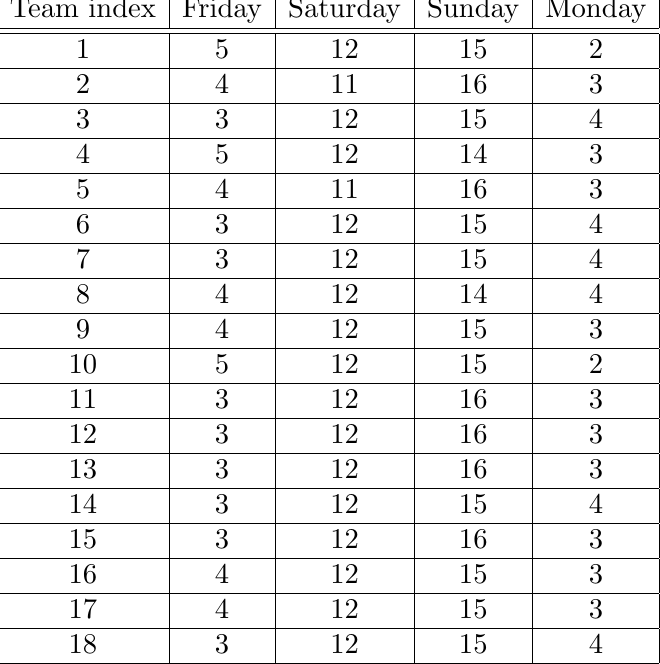
Table 6. Seasonal matchday distribution of games for each team obtained by the optimal